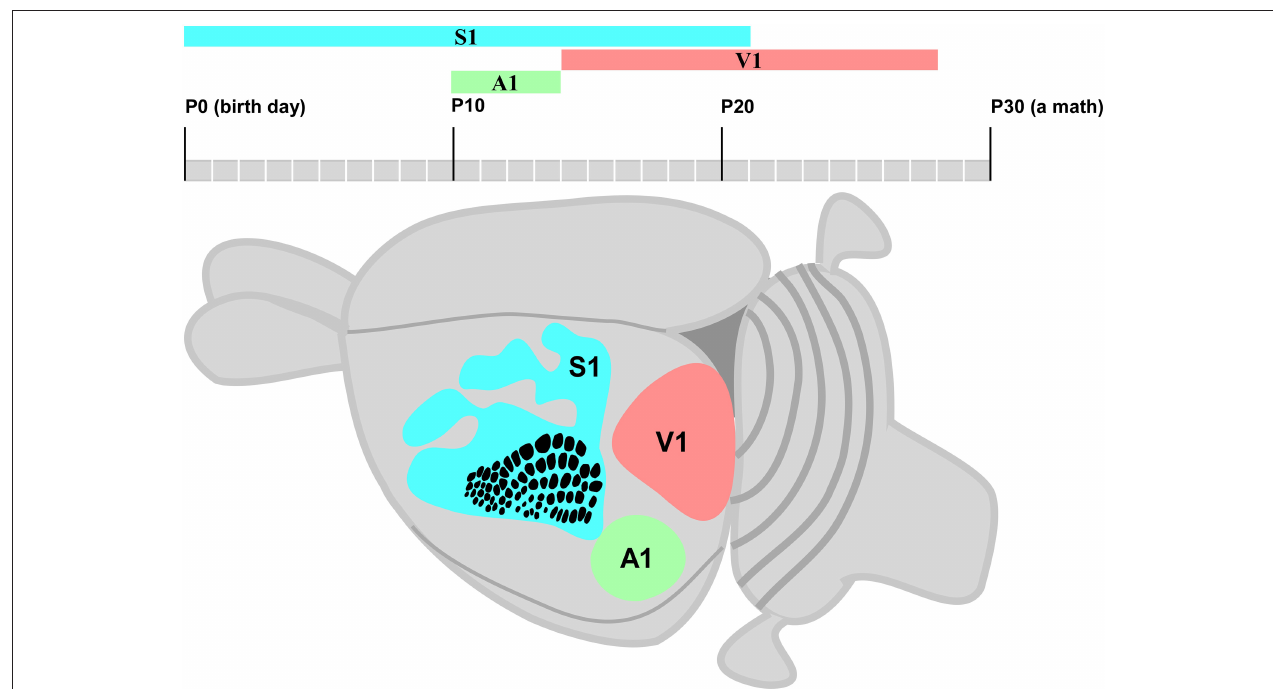
FIGURE 5 | Schematic diagram of a small rodent brain highlights S1 (blue), A1 (green), and V1 areas (pink). The posteromedial barrel subfield (PMBSF) cortex in S1 is highlighted by a point-to-point representation of whiskers; rows and receptive fields are represented by a single whisker.